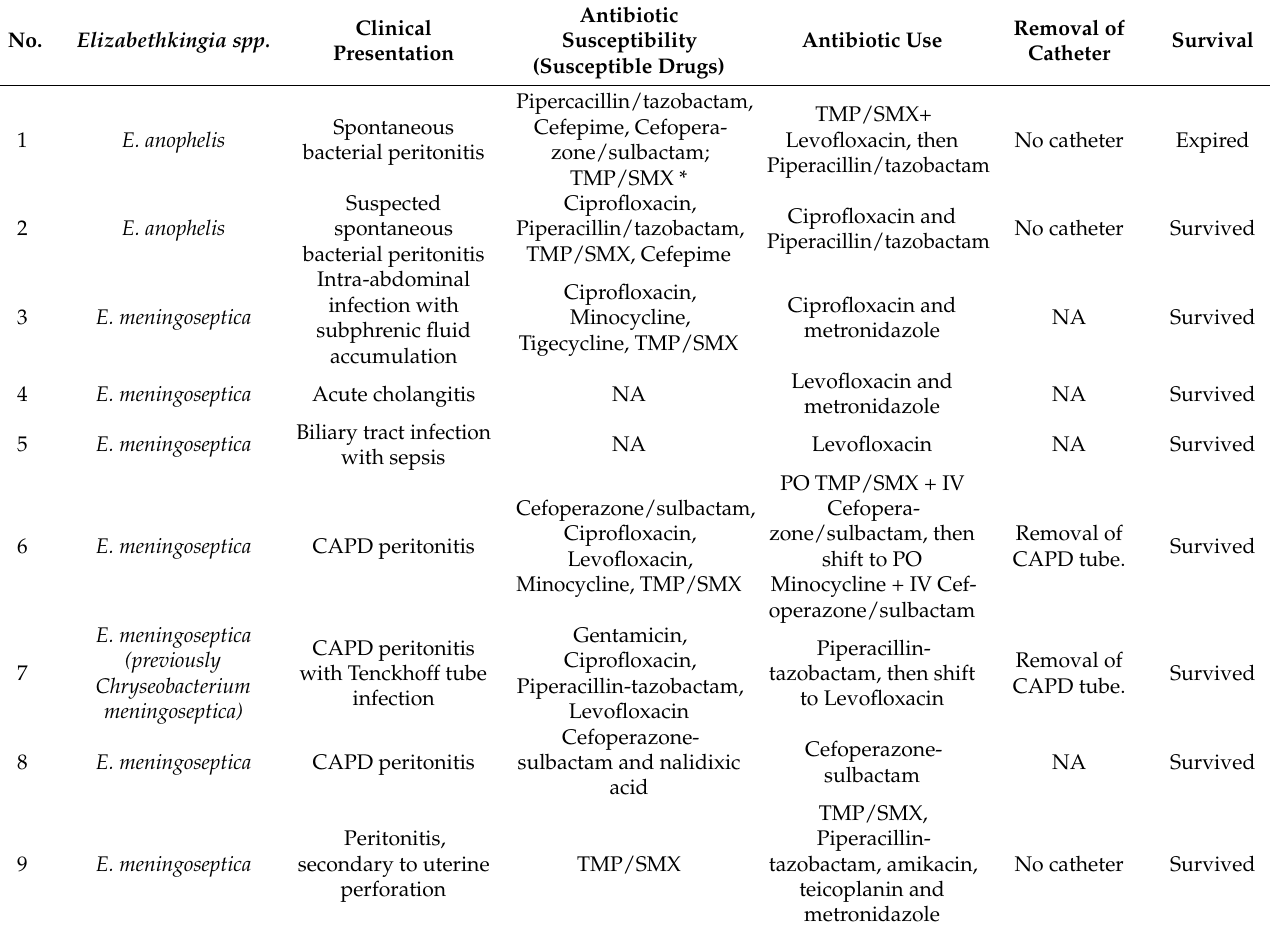
Table 2. Treatment for Intra-abdominal infection with Elizabethkingia